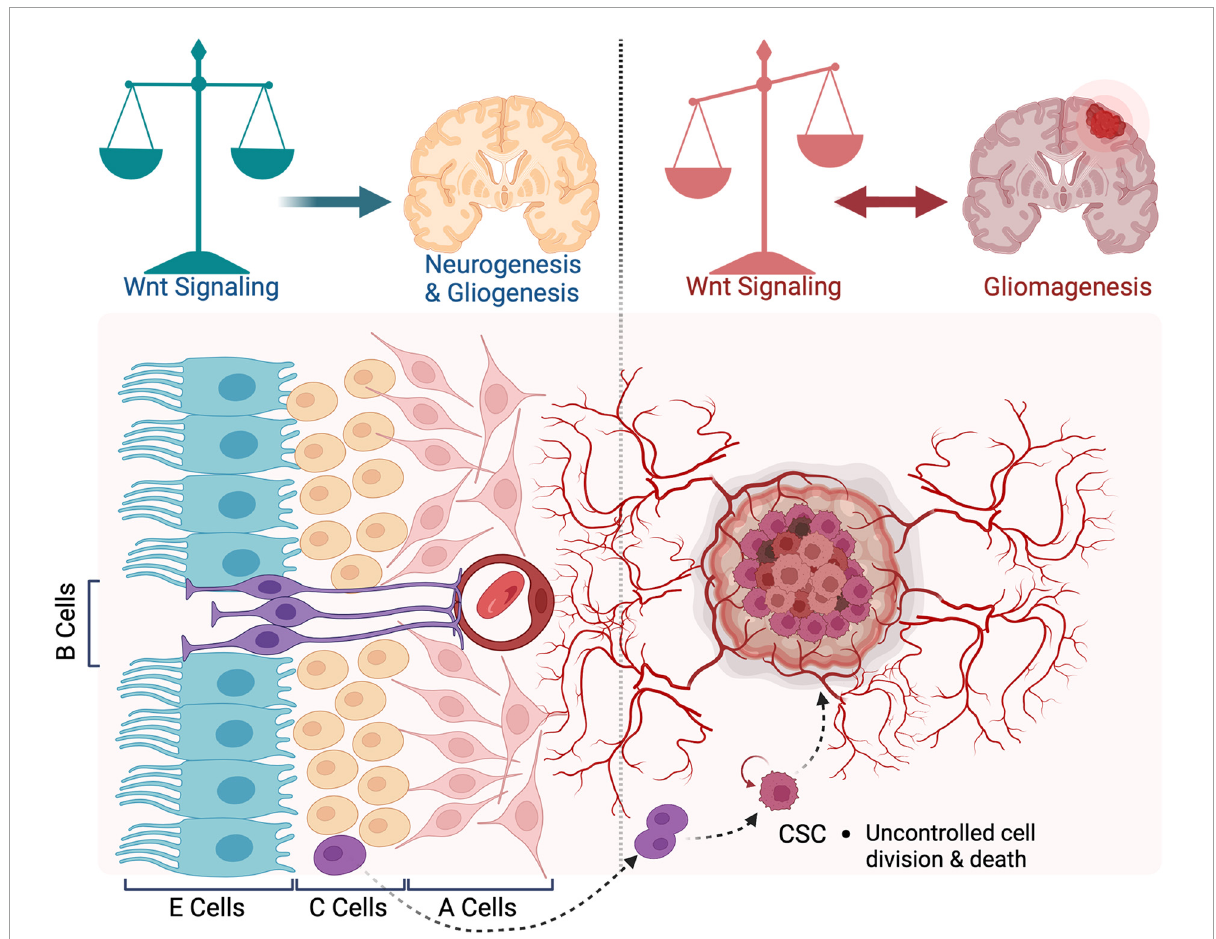
FIGURE1 Organization of the subventricular zone in health and disease. A schematic representation of the subventricular zone (SVZ) neurogenic niche in adult brain. During neurogenesis, WNT signaling regulates the balance between proliferation and differentiation of neural stem cells (NSCs). In gliomagenesis, WNT promotes the ETM-like process and migration of cancer stem cells. Blocking WNT inhibits the proliferation of tumor cells. In turn, WNT signaling is activated by oncogenes expressed in glioblastoma (GBM)